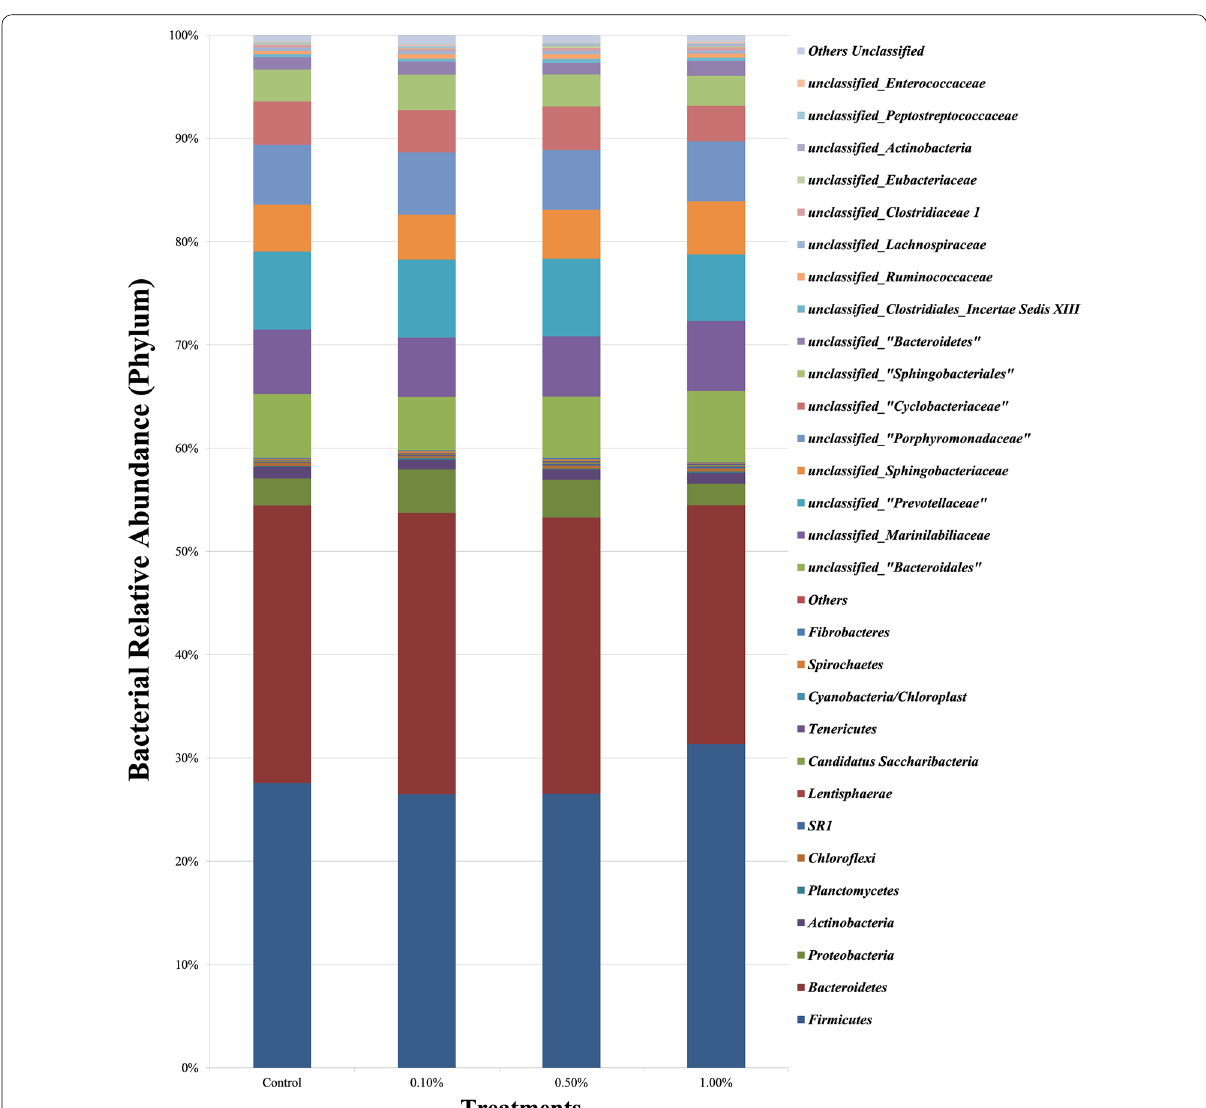
Fig. 1 Bacterial phylum‑level compositions of the control and Enterococcus faecium SROD‑supplemented rumen fermenta. The data portray phylum‑level 16S rRNA pyrotagged gene sequences. Sequences were classified using the RDP naive Bayesian rRNA Classifier with an 80%